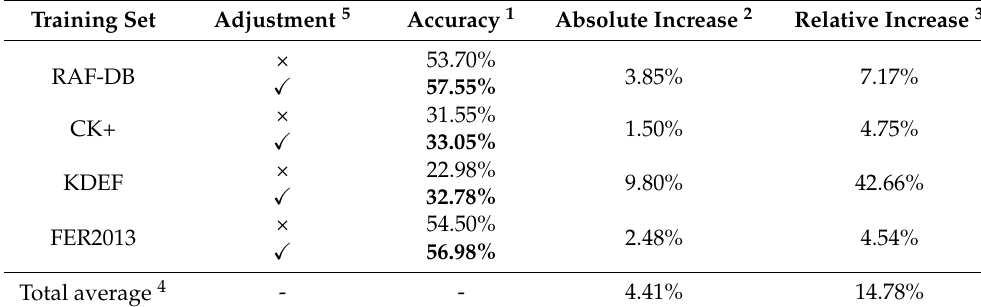
Table 4. Improvements in accuracy relative to real sample